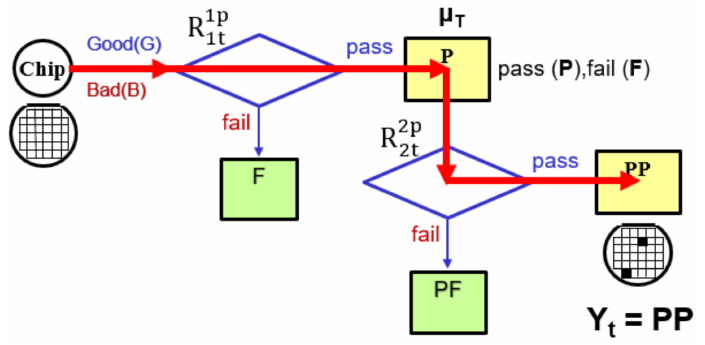
Figure 7. Schematic diagram of the repeated testing (R 2p